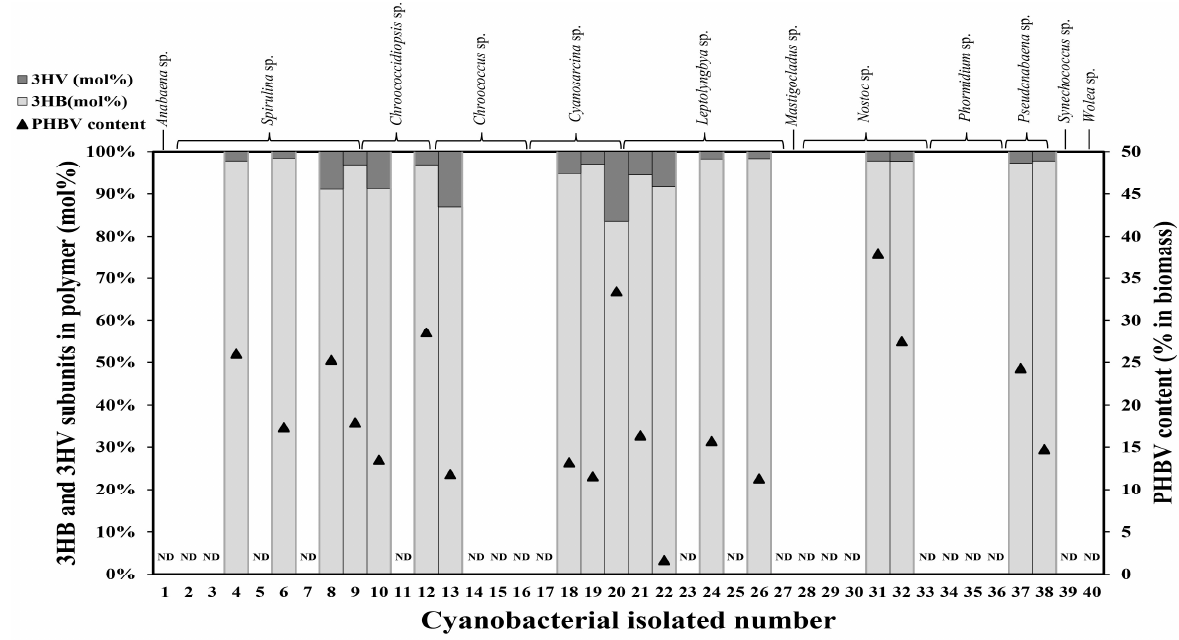
Figure 1. poly(3-hydroxybutyrate-co-3-hydroxyvalerate) (PHBV) production screening in 40 cyanobacterial strains sup- plemented with 0.4% ( w / v ) sodium acetate and 0.4% ( w / v ) sodium propionate under heterotrophic conditions. N.D., no detected polymer production by GC analysis.